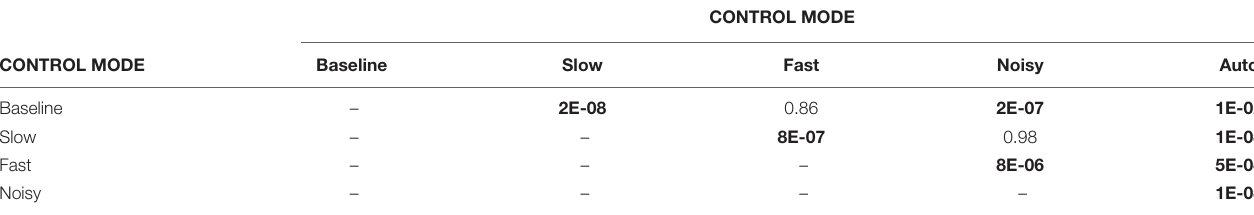
TABLE 3F | Post hoc comparisons ( p -values) for performance across control modes on compliant